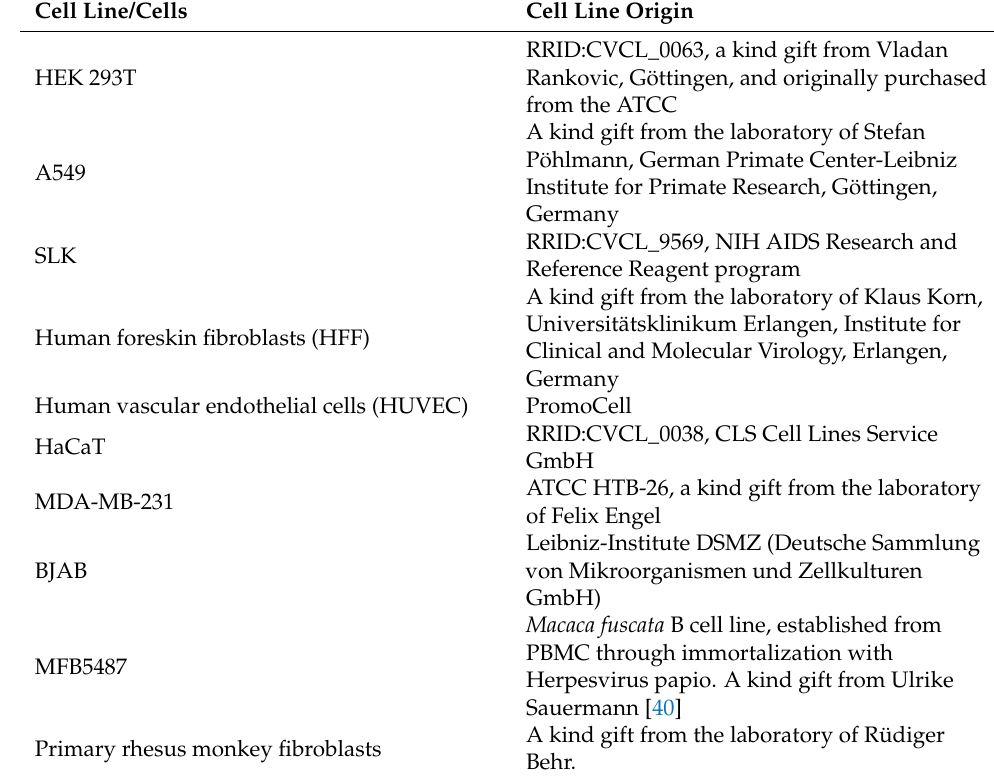
Table 2. Cell lines.